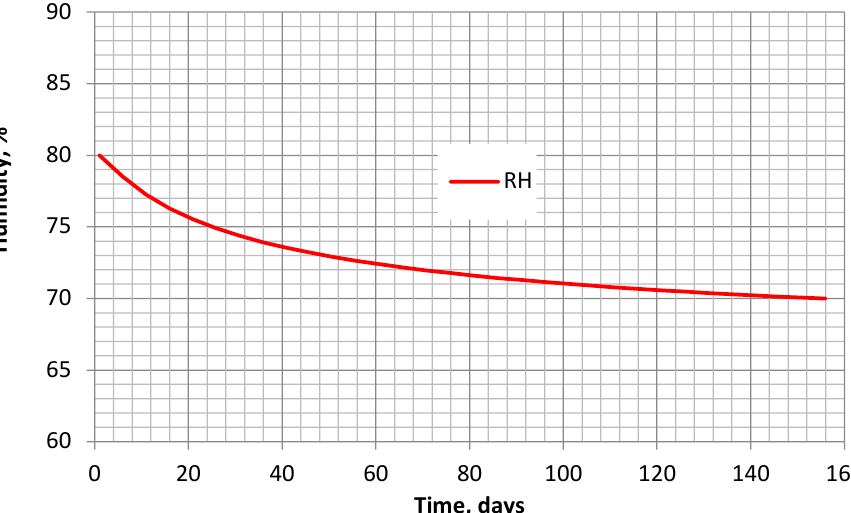
Figure 15. Dependence of humidity (from 80% to 70%) on time.